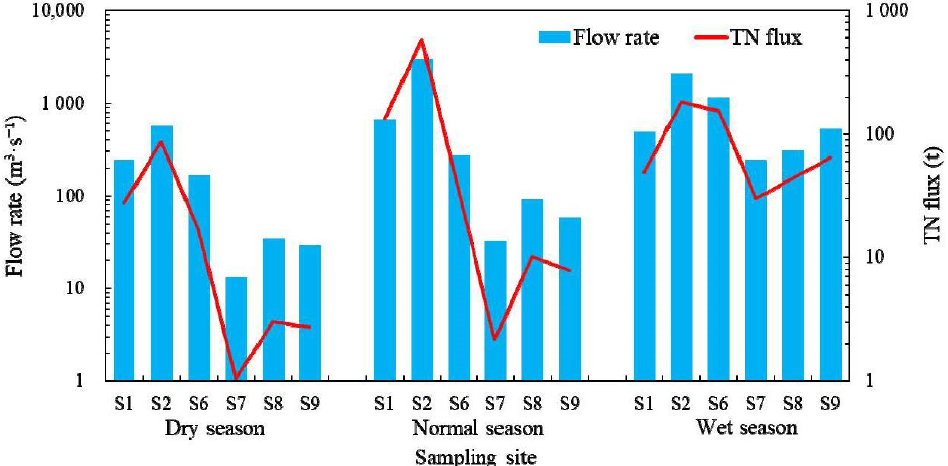
Figure 7. Flow rates and TN fluxes of the sampling sites in the Yangtze River system and the local river system during the three monitoring periods.